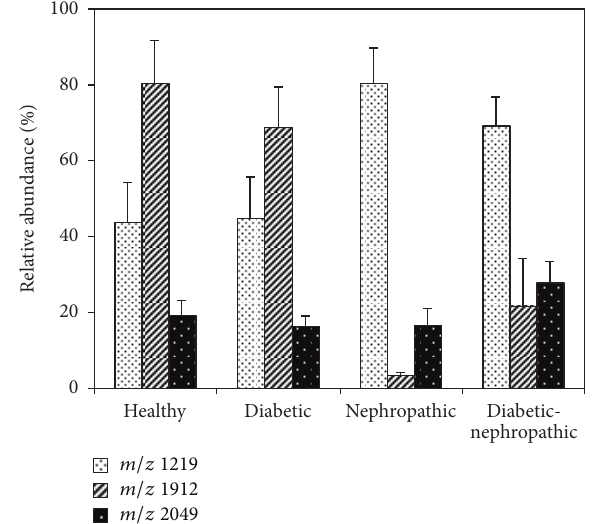
Figure 10: Histograms of the abundances of ions at 𝑚/𝑧 1219, 1912, and 2049 as found in urine samples of subjects under study. Data are expressed as mean ±